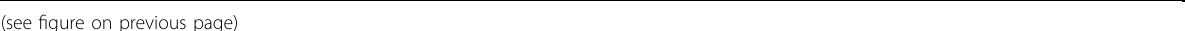
Fig. 3 GSTZ1 overexpression enhances sorafenib-induced ferroptosis in HCC. A Representative TEM images of the mitochondrial morphology in GSTZ1-OE SK-Hep1 and GSTZ1-KO HepG2 cells treated with 10 μ M sorafenib for 24 h. Red arrows indicate mitochondria. Scale bar = 1 μ m. B Representative images (top) and quanti fi cation (bottom) of ROS level in GSTZ1-OE and GSTZ1-KO cells treated with sorafenib for 24 h. Scale bar = 20 μ m. C , D The intracellular iron ( C ) and MDA ( D ) levels in GSTZ1-OE and GSTZ1-KO cells treated with sorafenib for 24 h. E – G mRNA and protein levels of target genes associated with ferroptosis in GSTZ1-OE and GSTZ1-KO cells treated with sorafenib or erastin, determined via qRT-PCR ( E , F ) and western blotting ( G ), respectively. For western blotting, 50 μ g protein was loaded per well. Values represent the mean ± SD ( n = 3). The qRT-PCR data determined from three independent experiments. ns: no signi fi cant difference, * p < 0.05, ** p < 0.01, *** p < 0.001, Student ’ s t -test (two